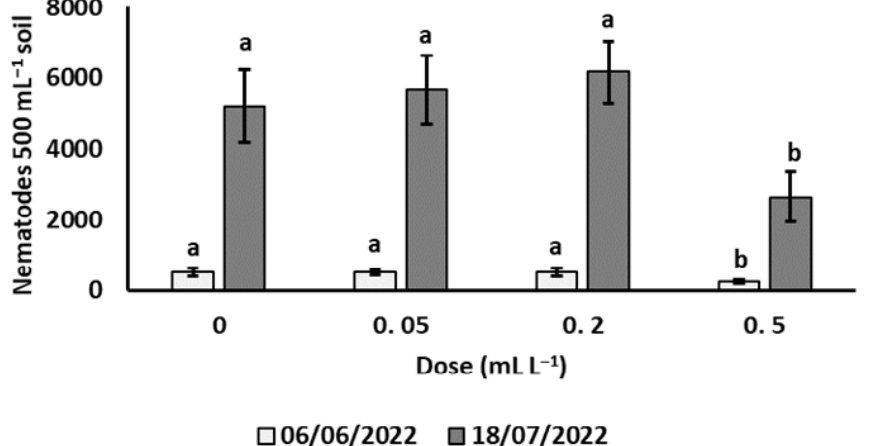
Figure 1. Effect of soil treatments with garlic extract formulation on soil population density of Xiphinema index on potted grapevine. Values are means of seven replicates ± standard errors. At each sampling date, bars marked by the same letters are not significantly different according to the Least Significant Difference Test ( p ≤ 0.05).